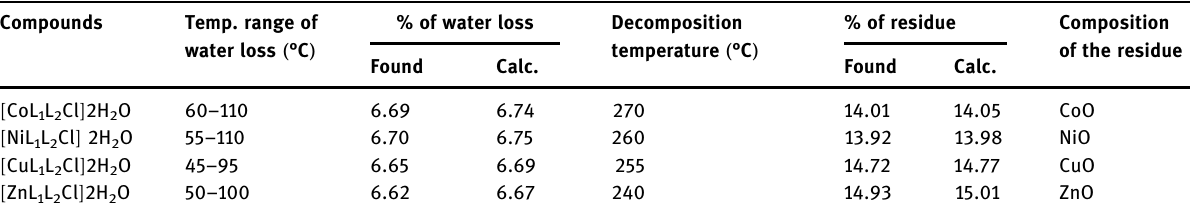
Table 2: TGA data for the ternary compounds Compounds Temp. range of